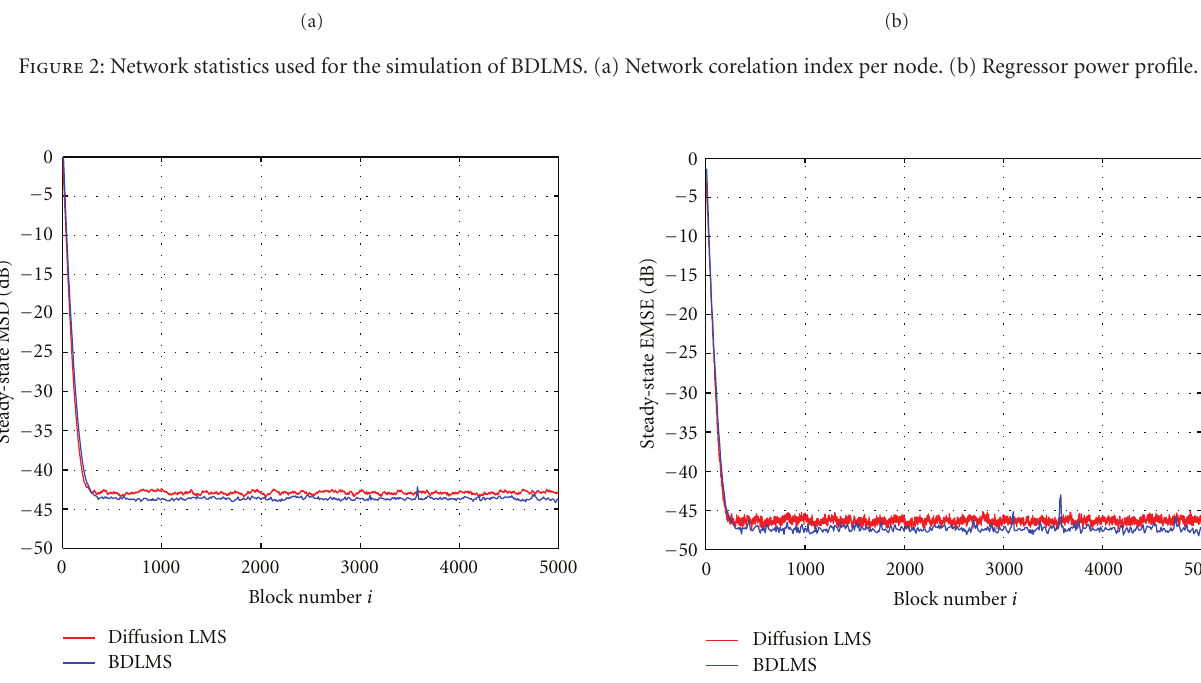
Figure 4: Global excess mean-square deviation (EMSE) curve for di ff usion and block di ff usion